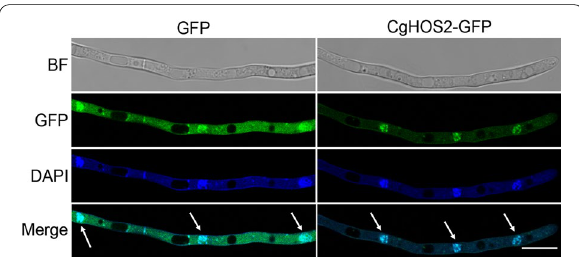
Fig. 2 Subcellular localization of CgHOS2. Fungal hyphae were visualized by confocal laser scanning fluorescence microscopy. The arrows indicate nuclei. BF, bright field. DAPI, 4’,6-diamidino-2-phenylindole. Scale bar